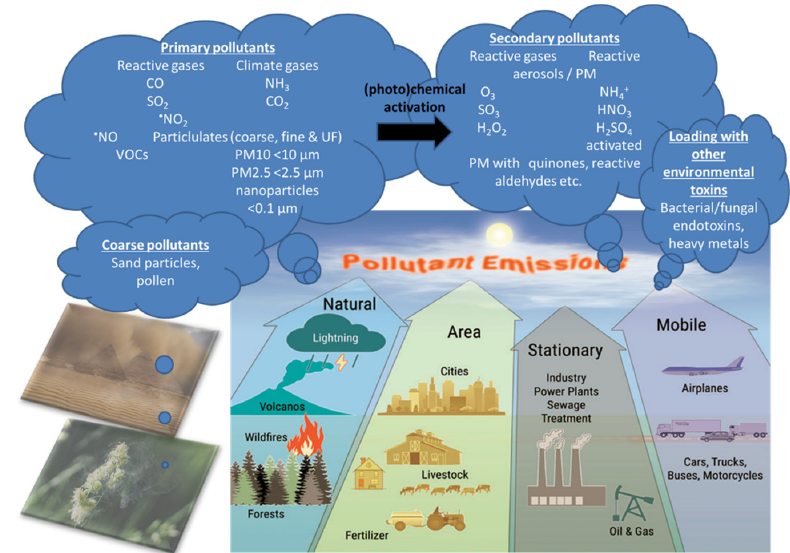
Figure 2. There are four main types of air pollution sources including natural, area, stationary, and mobile sources producing PM0.1, PM2.5, PM10, reactive gases including volatile organic compounds (VOCs). Primary pollutants (the indicated gases and solid particles) may undergo further toxification in the environment, e.g., by photochemical reactions by UV light producing more reactive gases or more toxic carbohydrate products on the particle surface (termed particle “aging”) [12] as well as